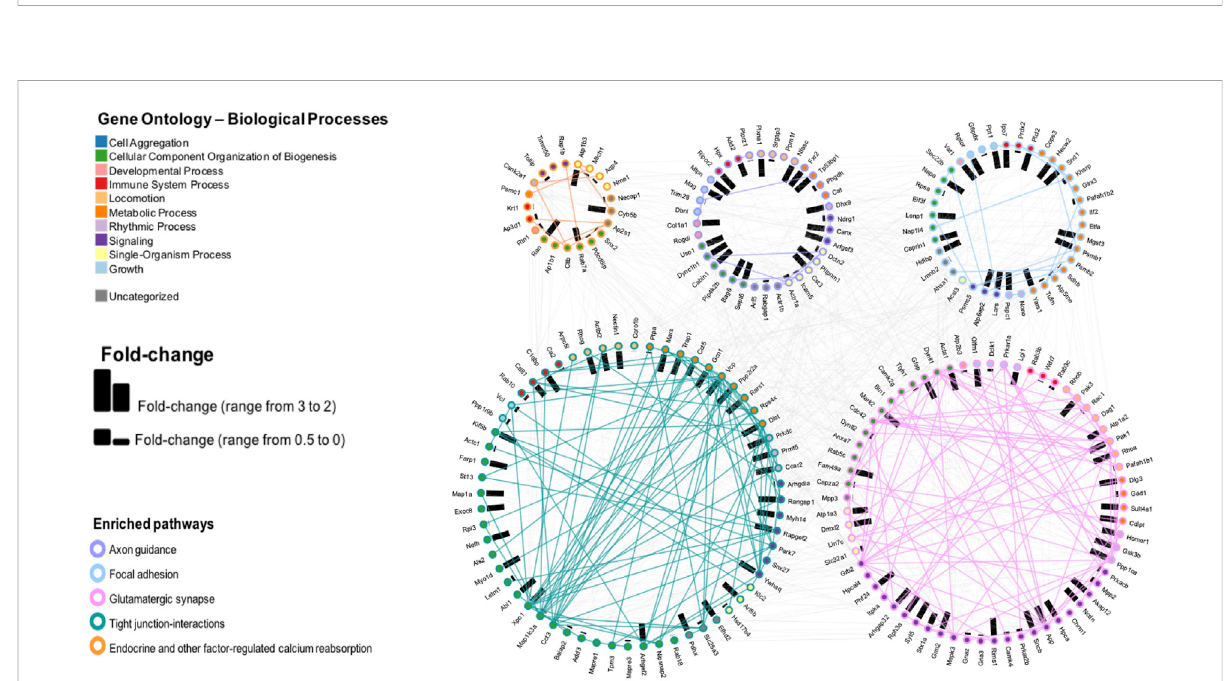
Pathway enrichment analysis and visualization of the protein interactions with a protein-protein interaction (PPI) network of fi ve pathways selected from the CPA analysis. Fold changes are depicted by bars, representing change in either